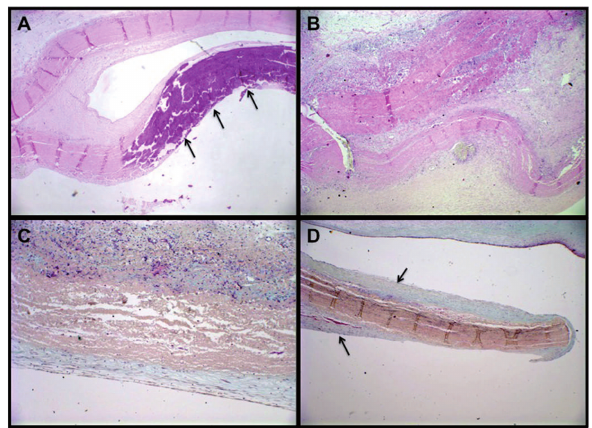
Fig. 2 – Análise histológica. Avaliação histológica dos enxertos. Em A, fotomicrografia em hematoxilina-eosina 40x do grupo GDA demonstrando degeneração da cúspide (seta). Em B, grupo DESCEL com a mesma coloração evidenciando o infiltrado inflamatório com a matriz preservada. Em C, pentacrômico de Russel-Movat’s, com matriz degenerada e poucos glicosaminoglicanos. Em D, enxerto DESCEL com a mesma coloração, com a matriz preservada e grande quantidade de glicosaminoglicanos na hiperplasia intimal (setas)